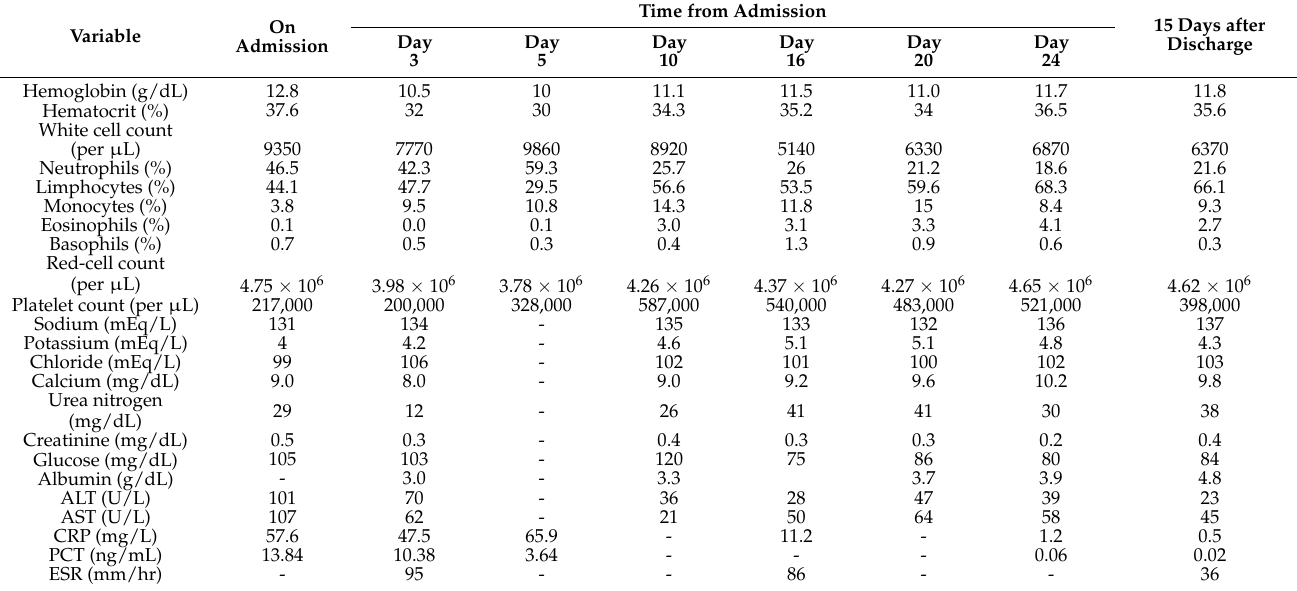
Table 1. Laboratory findings on admission and during follow-up in a 4-year-old immunocompetent child with atypical